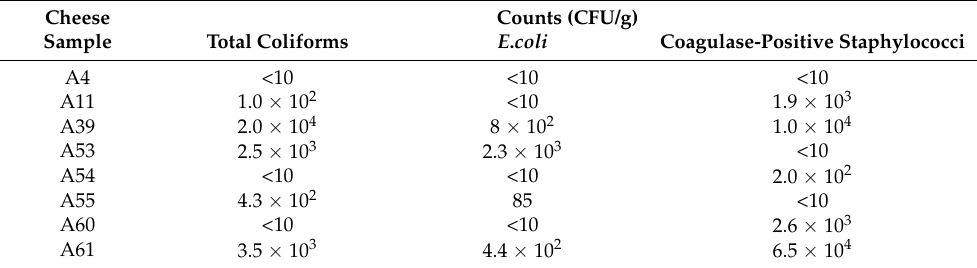
(Table 2), while the majority of positive samples for L. monocytogenes were negative for total coliforms, E. coli , and staphylococci (Table 3). Table 2. Hygiene indicators in Salmonella spp.-positive Minas artisanal cheese samples. Cheese Sample